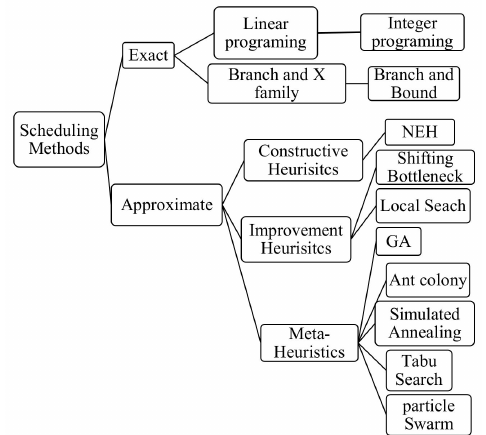
Figure 7. Classification of methods used to solve scheduling